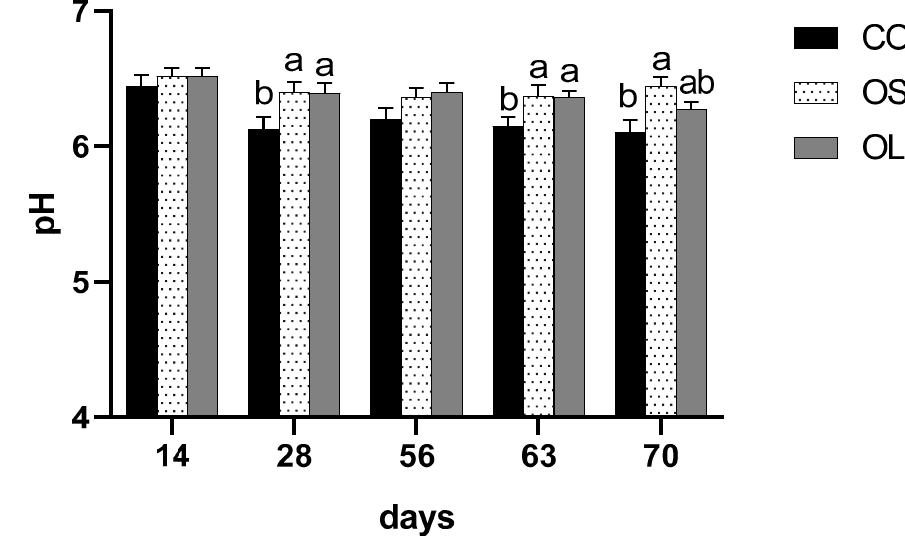
Figure 4. Ruminal pH for Holstein female calves fed basis diet without hay (CON: black bar) and inclusion of short oat hay (OS: 3–5 cm, spots bar) or inclusion of long oat hay (OL: 10–12 cm, gray bar). Different letters within a time point indicate significant differences among treatments ( p < 0.05). Different lowercase letters (a, b, ab) above the bar indicate significant difference ( p < 0.05).